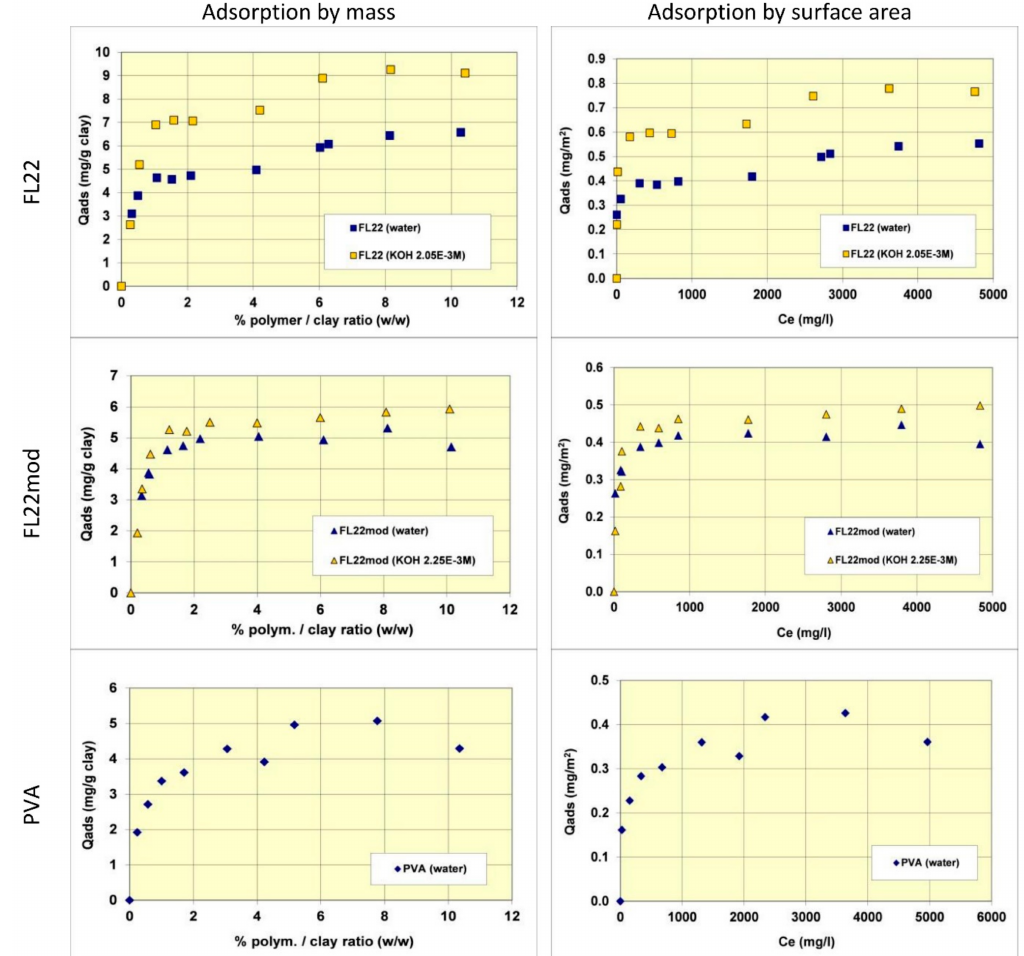
Figure 5. Adsorption isotherms for the polymers, FL22, FL22mod and PVA on kaolinite. The left hand column shows adsorption by mass, while the right hand shows adsorption as a function of surface area. For the ammonium based polymers the effect of pH is also tested with natural and high pH conditions